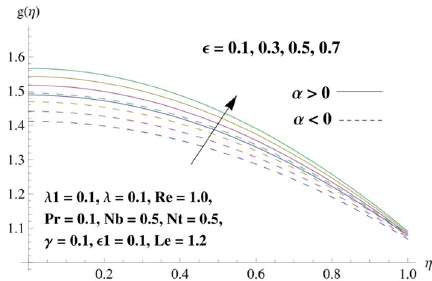
Figure 8. Behavior of g (η) against